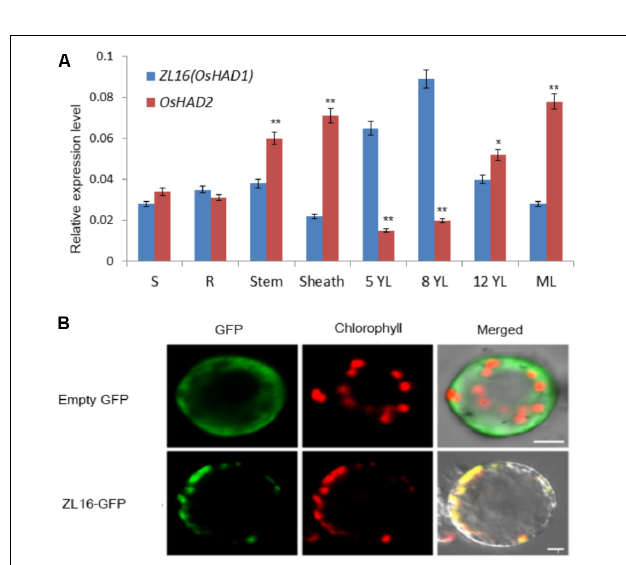
FIGURE 8 | Expression pattern and subcellular localization of ZL16. (A) Expression analysis of ZL16 ( OsHAD1 ) and OsHAD2 genes in rice various tissues. S, seed; R, young root; ML, mature leaf during flowering; 5, 8 and 12 YL, young top leaves from 5-, 8- and 12-day-old seedlings after germination. Ubiquitin gene was used as an internal control. Data are means ± SD of three biological replicates. For t -test, OsHAD2 values were compared with expression level of ZL16 ( OsHAD1 ). ∗ P < 0.05; ∗∗ P < 0.01. (B) Transient expression of ZL16–GFP in rice protoplasts. Empty GFP indicates